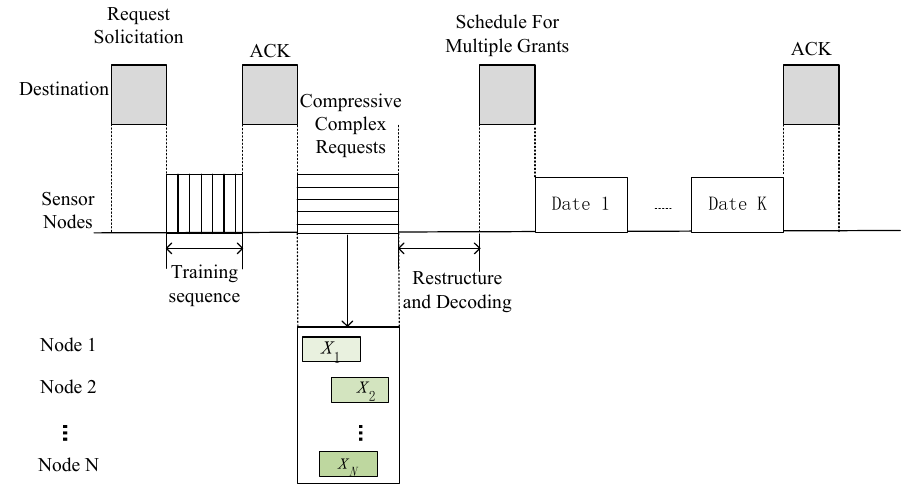
Figure 1. The cross-layer compressed sensing medium-access control (CL CS-MAC) scheme with asynchronous and random requests.